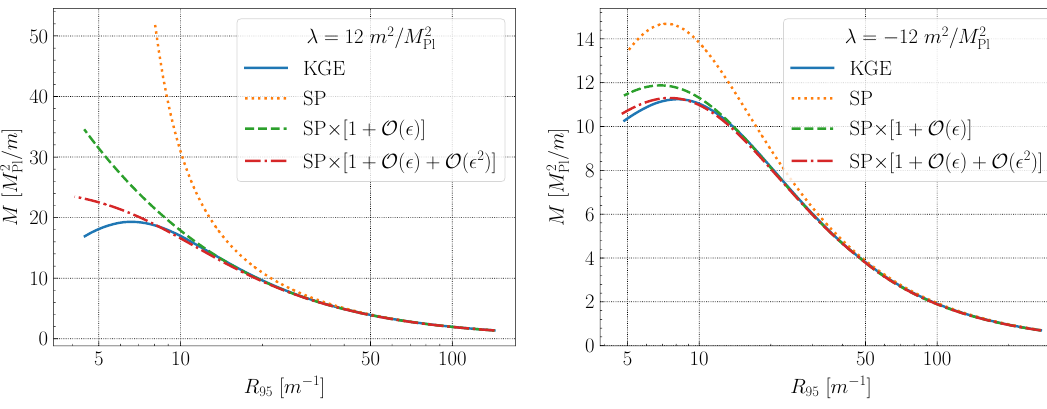
Figure 4 . A comparison of the mass-radius relation for theories with repulsive (left) and attractive (right) self-interactions. The results for much larger | λM 2 and ultra-light axions) can also be obtained within our EFT. In this case the deviations from the SP system with attractive self-interactions still appear at mR 95 . 50 . For the repulsive case, the deviation from the SP system becomes significant at larger and larger mR 95 as | λM 2